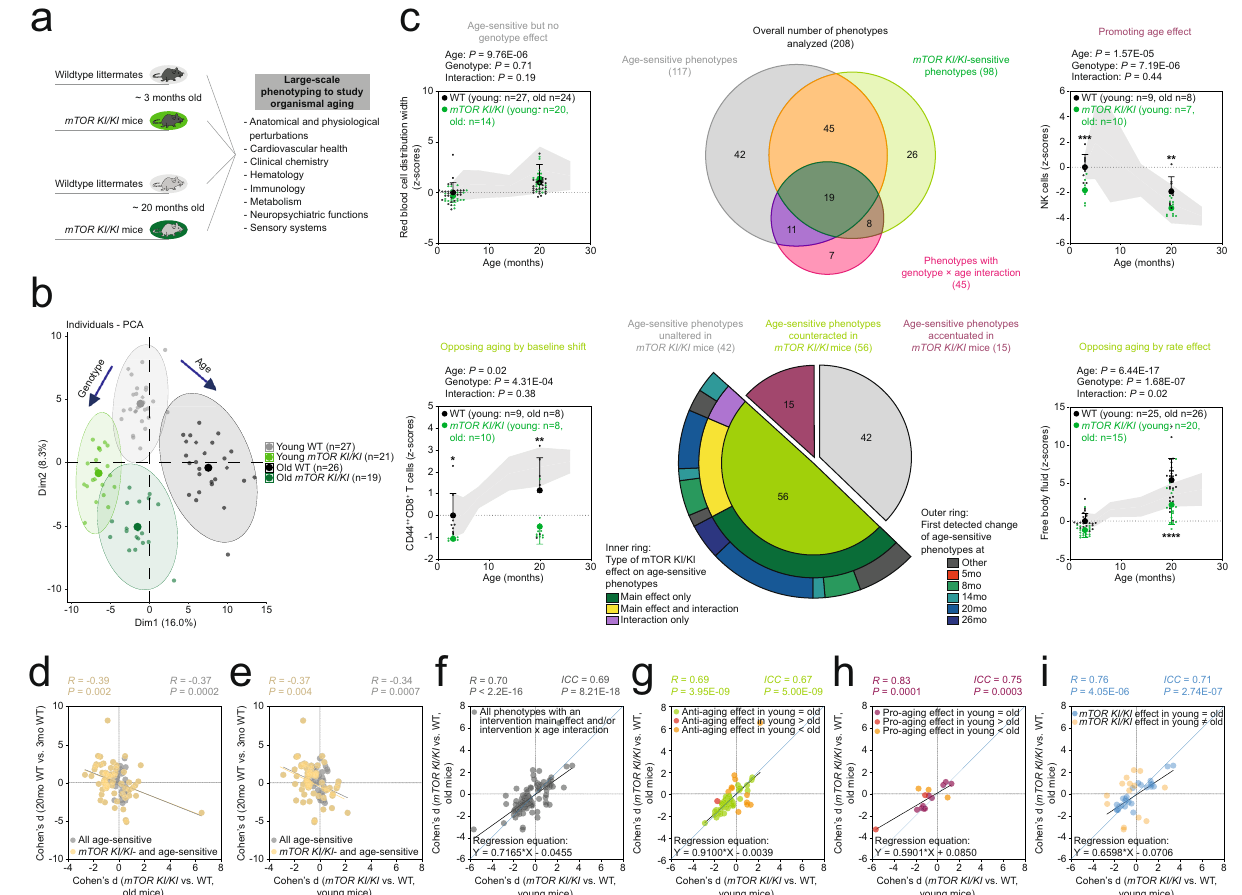
Fig. 6 | A hypomorphic mTOR mutant allele attenuated ASPs via a mixture of age-independent effects and effects more pronounced in old mice. a – i Deep phenotyping results in mTOR KI/KI mice. a Schematic illustration of study design. Mouse symbols adapted from ref. 10. b Principal component analysis of deep phenotyping data. c Venn diagram shows the number of ASPs, genotype-sensitive phenotypes, phenotypes with a genotype×age interaction and their intersection. Sunburst chart shows the number of ASPs either unaltered, counteracted or accentuatedbygenotype.ForASPscounteractedbygenotype,theinnerringshows theproportionofphenotypeswitheitheragenotypemaineffect,agenotype×age interactionorboth.TheouterringshowswhenchangesinthecorrespondingASPs were fi rstdetectedinourbaselinestudy.Linechartsshowrepresentativeexamples ofphenotypesin fl uencedbyageand/orinterventioninthedifferentpossibleways. Dataarepresentedasz-scores(normalizedtotheyoungWTgroup)andareplotted asmean+/ − S.D.(individualdatapointsaresuperimposed).Two-wayANOVAswith the between-subjects factors age and genotype followed by Fisher ’ s LSD posthoc